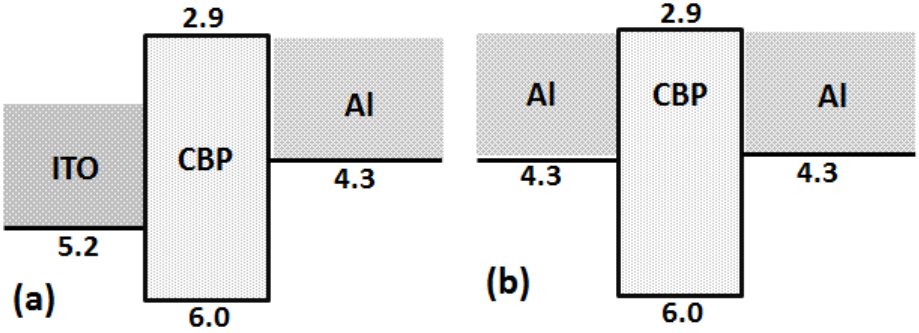
Figure 5. Schematic energy diagram of devices with the following device structure: ( a ) ITO/CBP/Al; and ( b ) Al/CBP/Al.